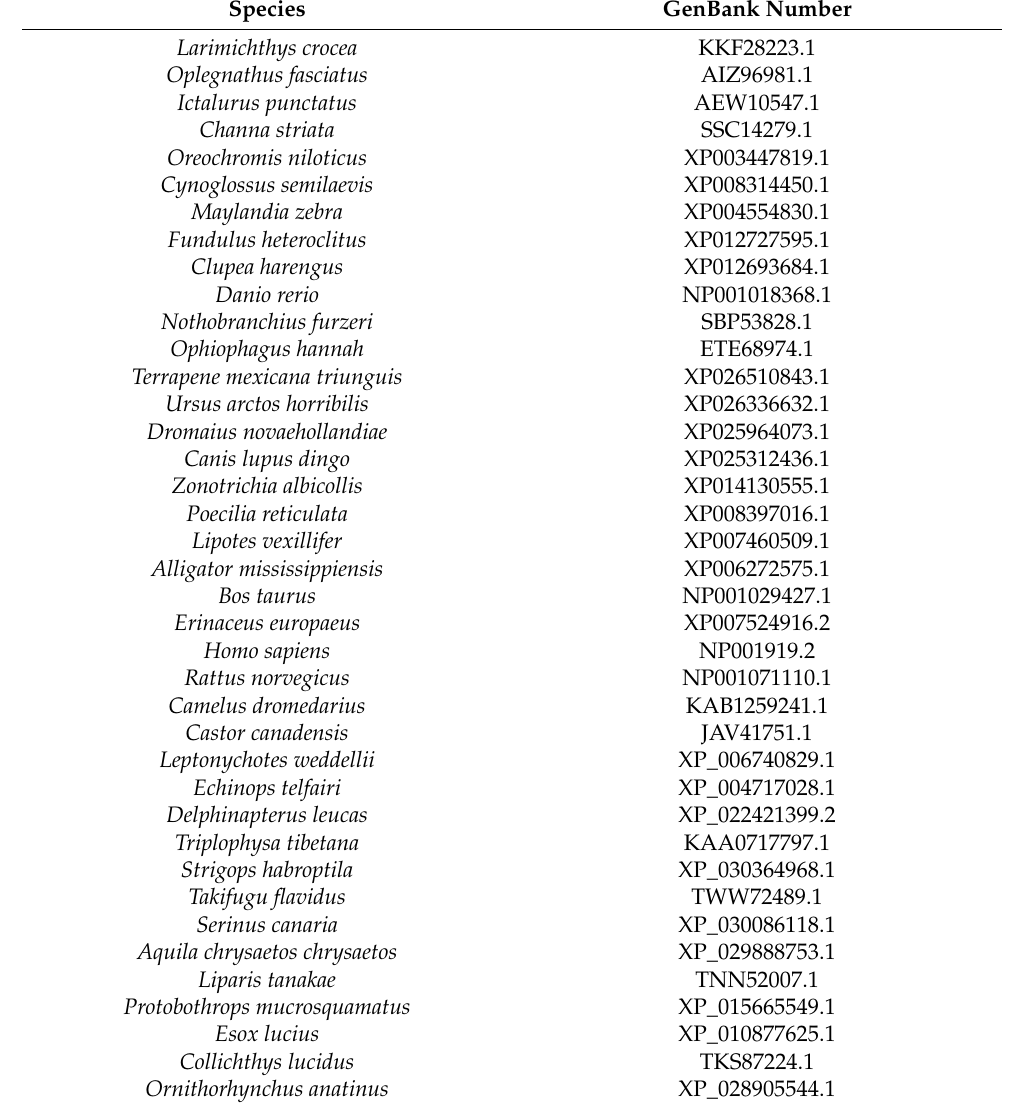
Table 2. The information of Dfs from different vertebrates used in phylogenetic